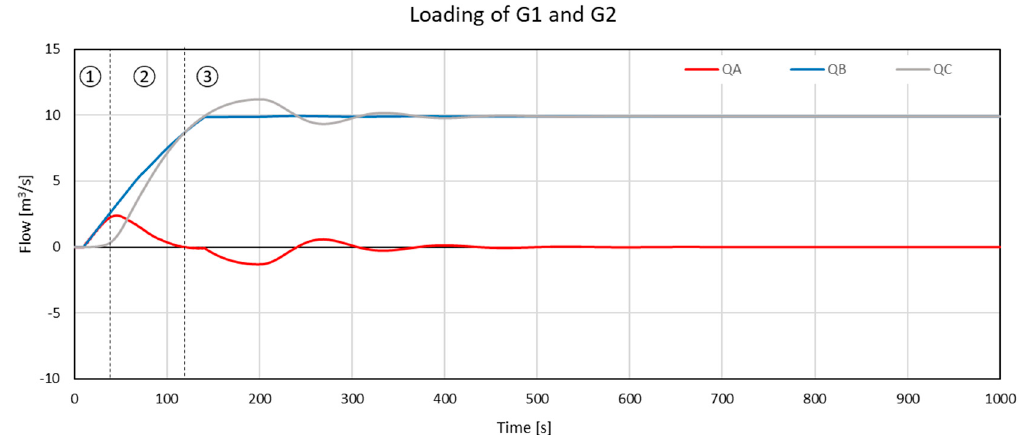
Figure 11. Flows through the three branches during loading of G1 and G2 .